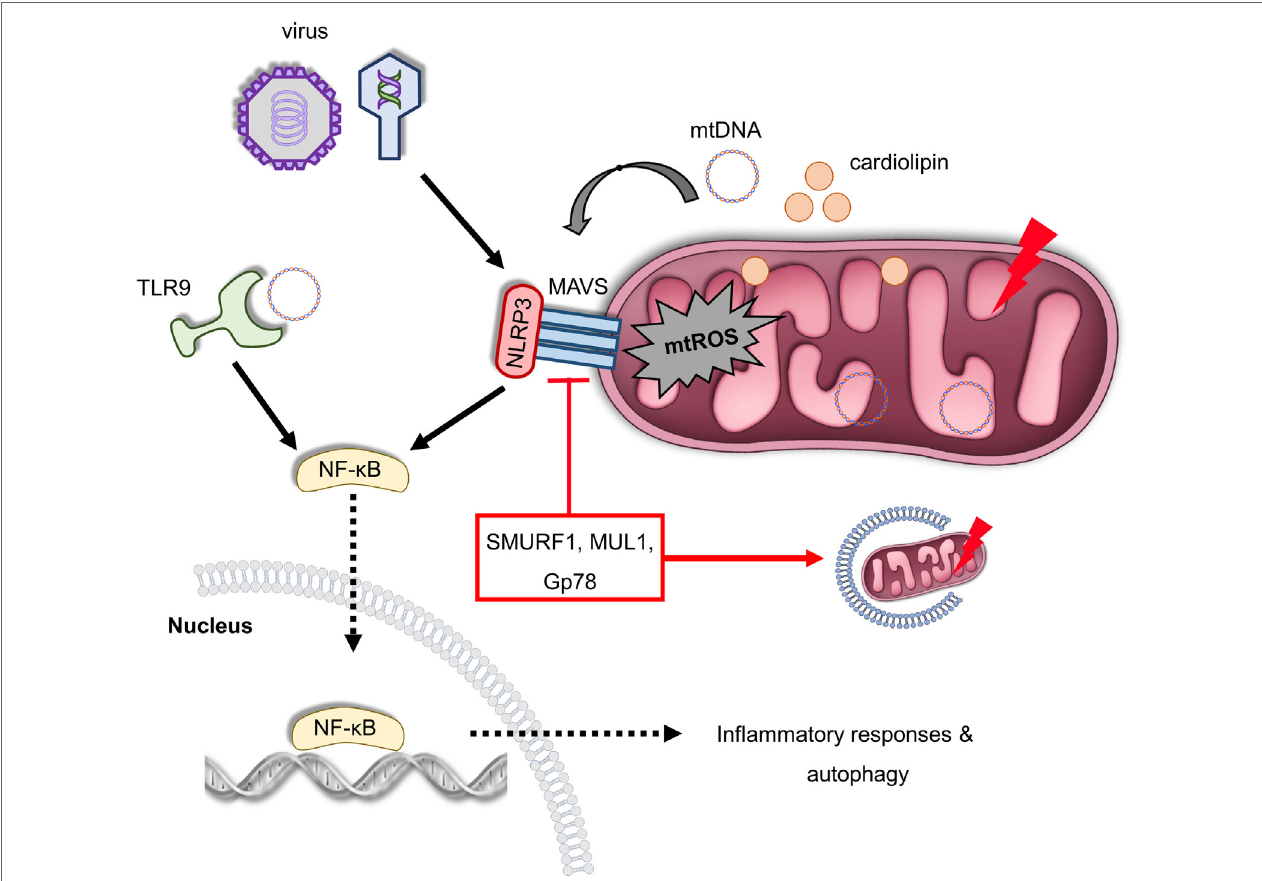
FiGURe 3 | Mitochondria act as a signaling platform of innate immunity. Viral infection triggers mitochondrial antiviral signaling protein (MAVS) oligomerization in OMM, which promotes the expression of several inflammatory and immune genes via nuclear factor- κ B (NF- κ B) activation. Furthermore, MAVS can be activated by excessive mitochondrial ROS (mtROS) production recruiting NLRP3 on the OMM in response to infection and mitochondrial damage. In turn, NLRP3 assembly and activity is enhanced due to elevated reactive oxygen species levels. In addition, depolarized mitochondria release cardiolipin and mitochondrial DNA (mtDNA) in the cytosol-stimulating NLRP3, which generates pro-inflammatory cytokines and mediates inflammation. mtDNA can be also sensed by toll-like receptor (TLR) 9 immune receptors promoting activation of both NLRP3 and NF- κ B. The immunosuppressive role of the ubiquitin E3 ligases SUMRF1, MUL1, and Gp78 is characterized both by the negative regulation of MAVS signaling and mitophagy stimulation. Thus, multiple innate immune signaling pathways, such as MAVS, NLRP3 inflammasome, and TLR9, depend on mitochondrial function to regulate immune